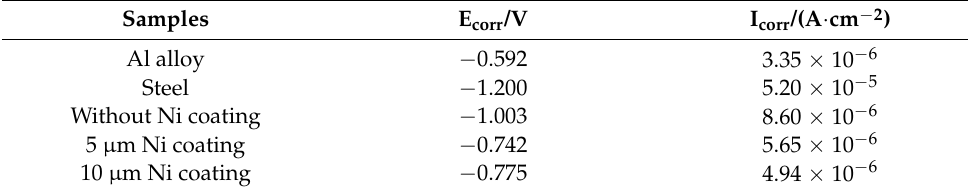
Figure 9. Polarization curves of Al alloy/steel joints with different thicknesses of Ni coating: ( a ) open circuit potential–time curves; ( b ) polarization curves. Table 4. E corr and I corr fitted for the curves in Figure